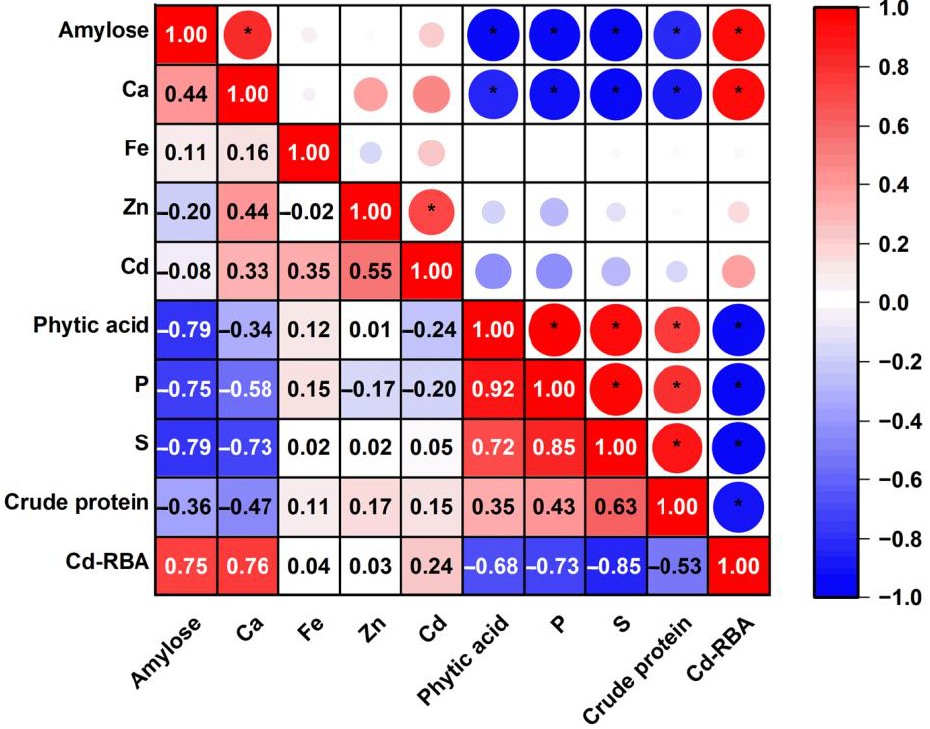
Figure 2. Pearson rank correlation between Cd-RBA and chemical composition in rice. Significant correlations are denoted by “*” ( p < 0.05).